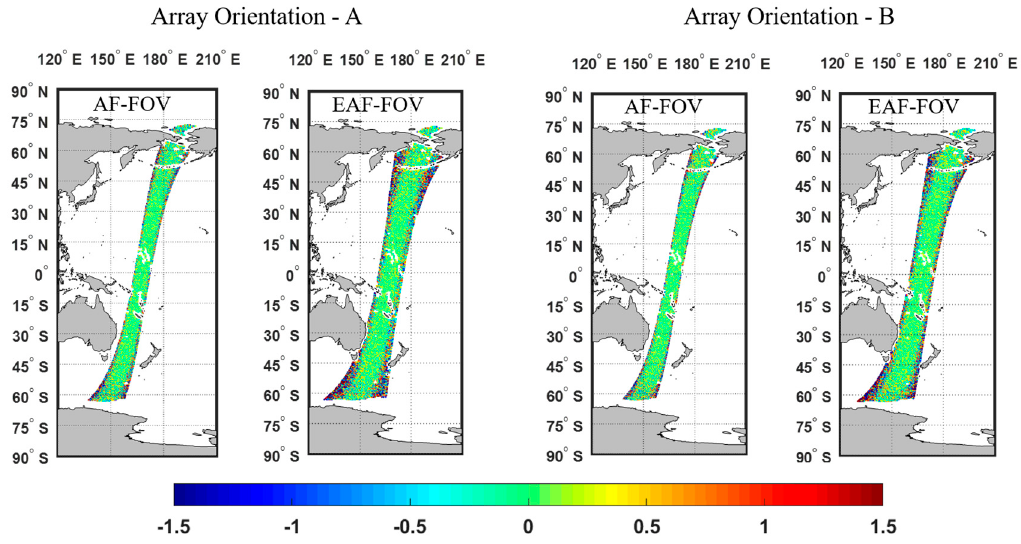
Figure 11. Illustration of the distributions of the SSS errors along one pass, considering the ideal case 1, i.e., with no errors in sea surface temperature (SST) and wind speed (WS). The results of array orientations A and B using TBs in the AF-FOV and in the EAF-FOV are presented, respectively. The color bar represents for the SSS retrieval errors in unit of psu.